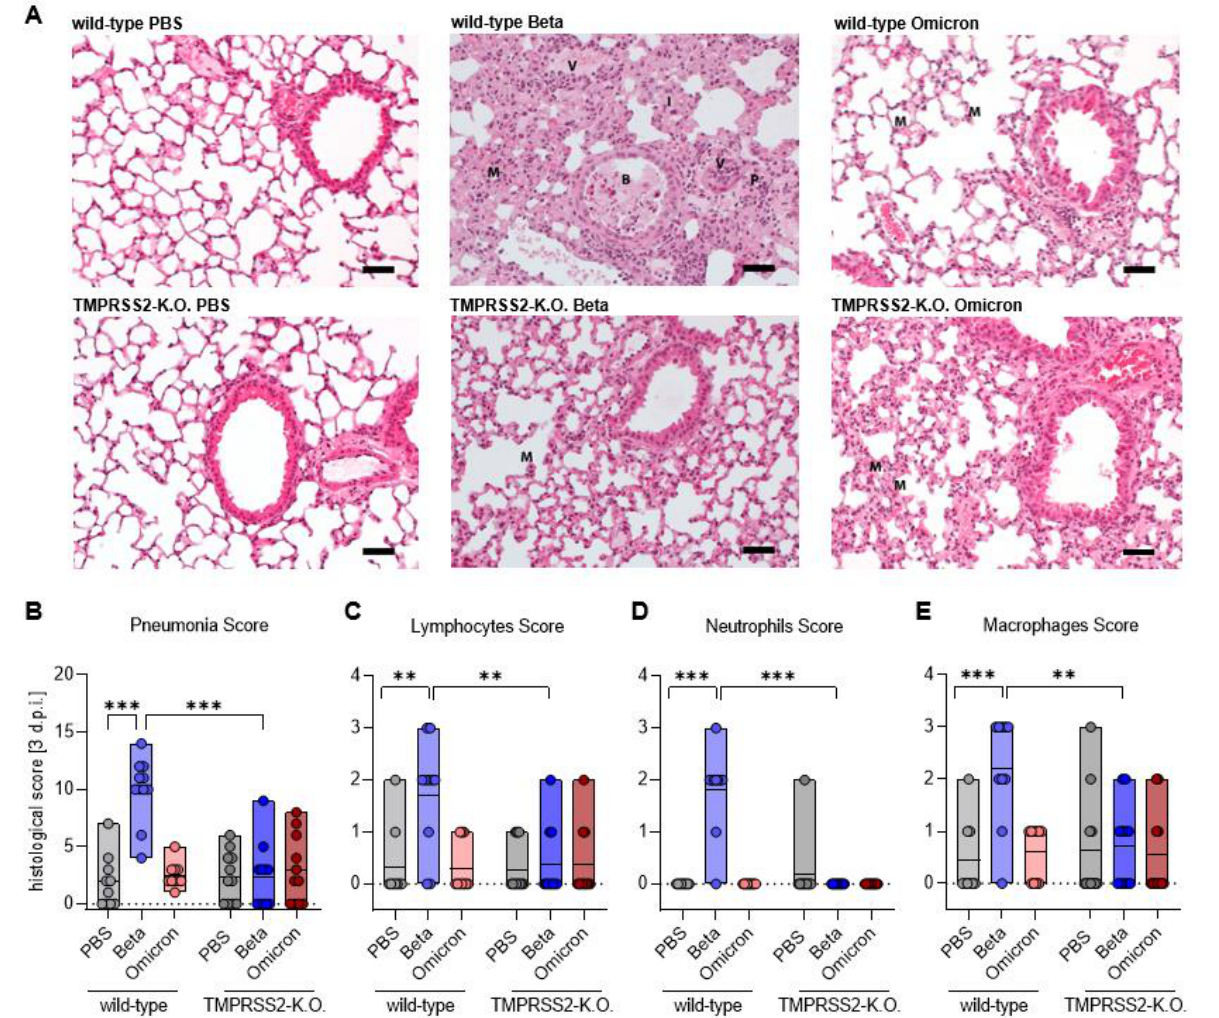
Figure 4. TMPRSS2 plays a crucial role in inflammatory lung damages of SARS-CoV-2 Beta infected mice. ( A ) Representative hematoxylin-eosin (HE) staining of lung tissue from PBS (top), Beta (middle) and Omicron (bottom)-infected wild-type (left) and TMPRSS2 KO mice (right). I = interstitial pneumonia, B = broncho-alveolar inflammation, P = perivascular inflammation and V = vasculitis, M = macrophages representing the severity of the individual parameters summarized in the Pneumonia score. Scale bar 50 µm. ( B ) For the pneumonia score, the following scores were cumulated: area affected by the pathological change, interstitial pneumonia, broncho-alveolar inflammation, perivascular inflammation and vasculitis. The severity of the parameters was classified as: 1 = mild, 2 = moderate 3 = severe. ( C – E ) The presence of inflammatory cells was estimated for: ( C ) Lymphocytes (left), ( D ) neutrophils (middle) and ( E ) macrophages (right): 1 = occasionally seen, 2 = easily visible, large amounts 3 = dominating inflammatory cell. ( B – E ) Data are shown as median. Statistical significance for was calculated using Welch’s t test (two-tailed) (** p < 0.01, *** p < 0.001).